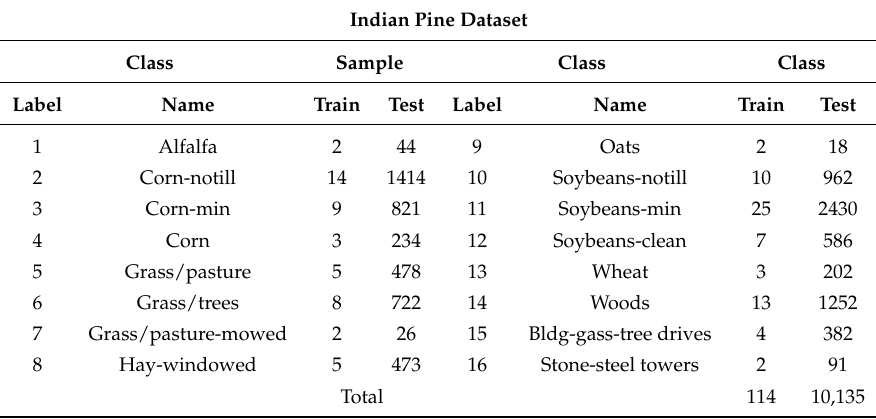
Table 2. Number of training and testing samples in each class for the Indian Pine dataset.